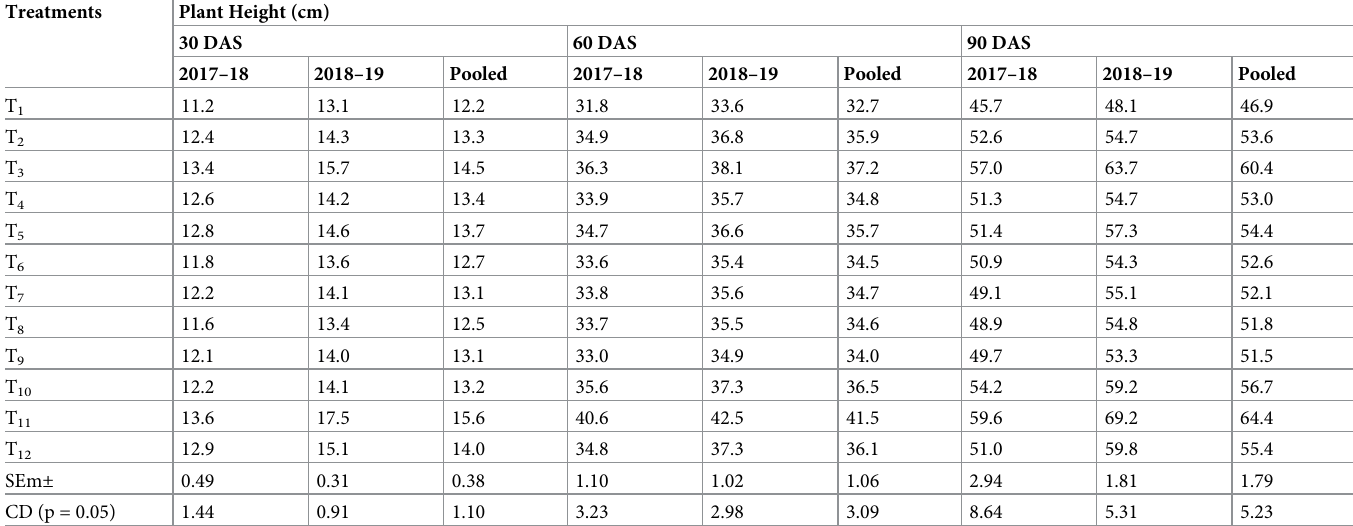
Table 2. Plant height of chickpea at different growth stages under various INM modules. Treatments Plant Height (cm)